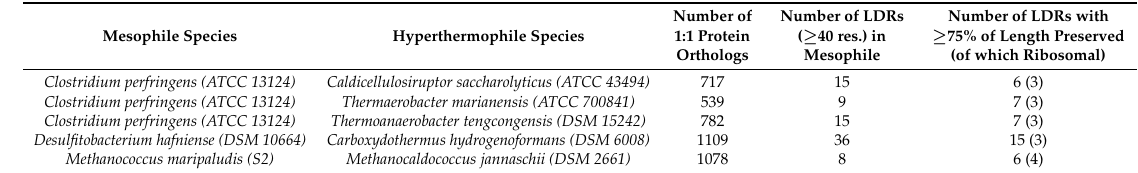
Table 1. Orthologous IUPred-predicted consecutive long disordered regions (LDRs) between mesophilic and hyperthermophilic